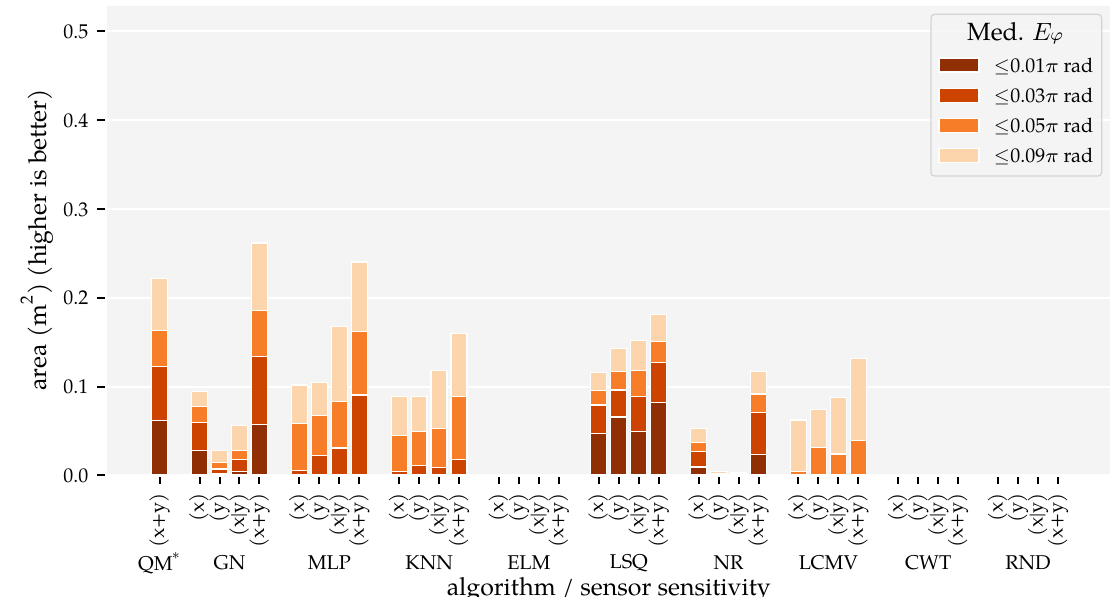
Figure 10. Total area with a median movement direction error E p (Equation (4)) below 1cm, 3cm, 5cm, and 9cm for varying sensitivity axes of the sensors: (x + y) measured both velocity components at all sensors, (x|y) alternated measuring v x and v y for subsequent sensors, (x) measured only v x at all sensors, (y) measured only v y at all sensors. This analysis method used the D s = 0.01 training and optimisation set and the σ = 1.0 × 10 − 5 ms − 1 noise level. The median movement direction error was computed in 2 × 2 cm 2 cells. Note, the bar for QM* is based on the D s = 0.01 condition in Analysis Method 1.